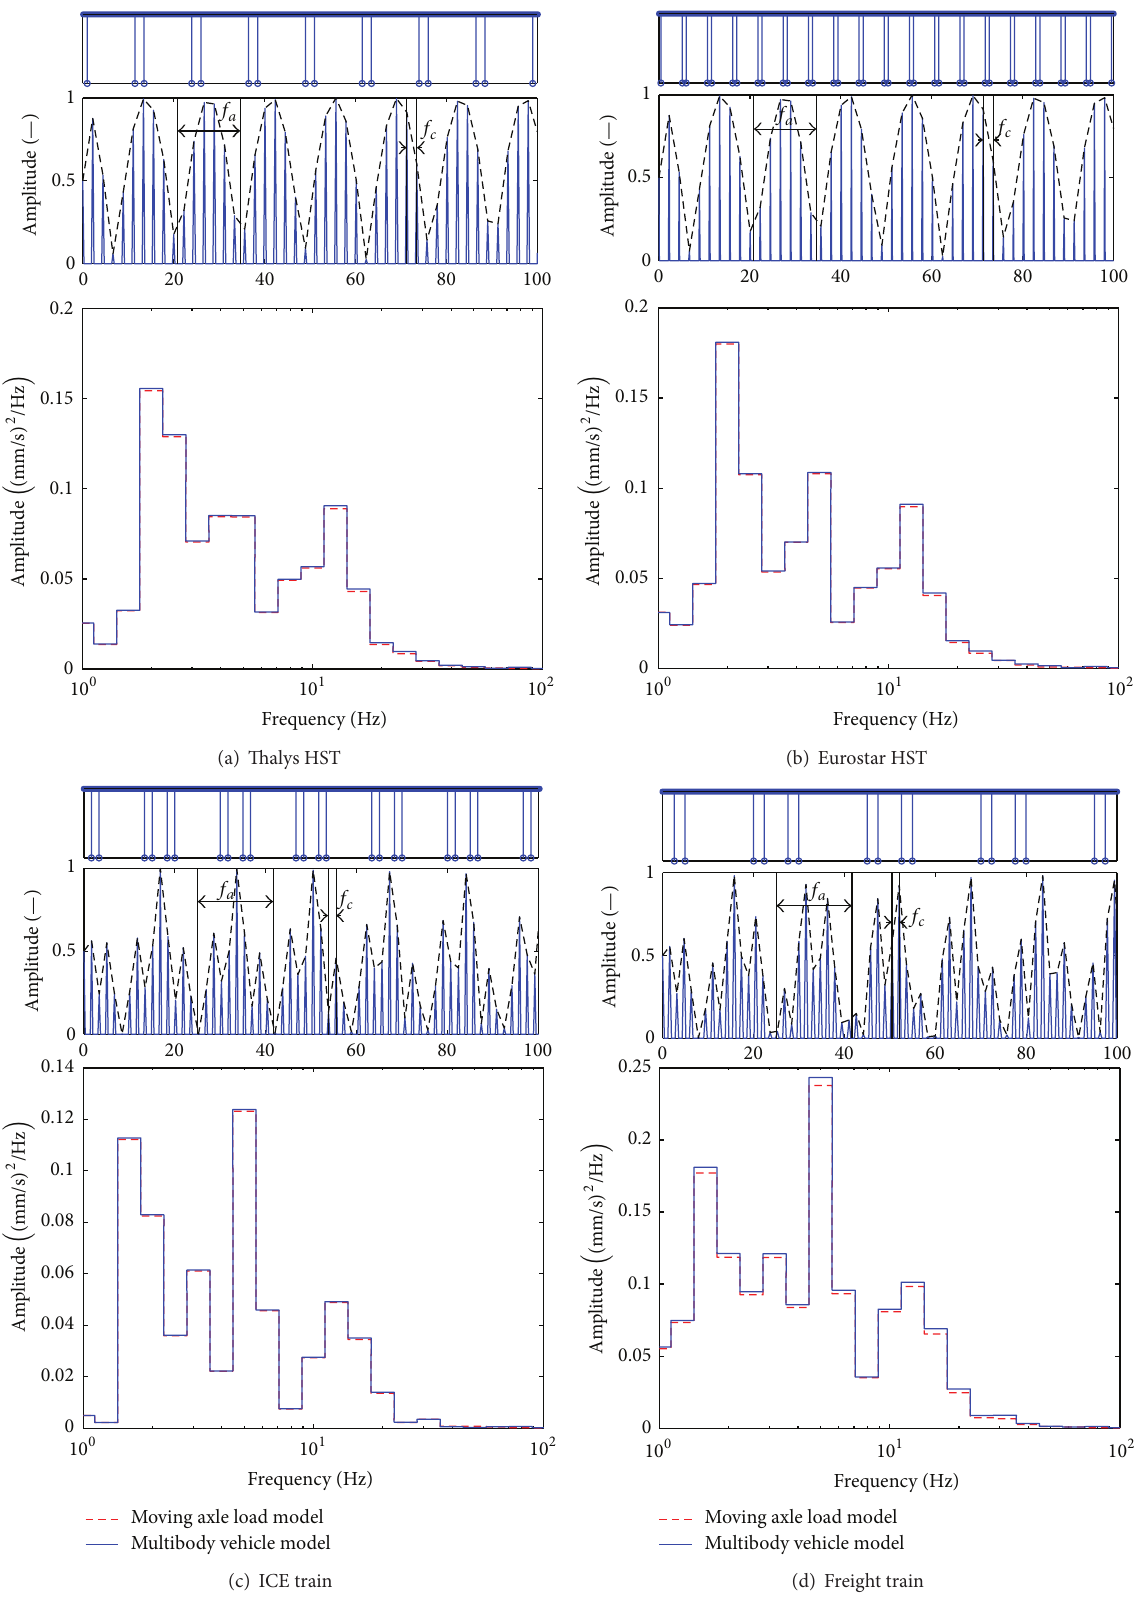
Figure 8: Frequency content of the vertical track deflection, as a function of the studied trains at speed V 0 = 150 km/h (for each subfigure, top: train passage excitation; bottom: one-third octave band